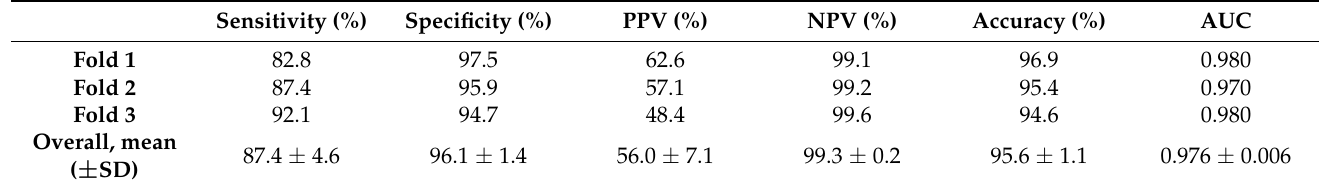
Table 2. Three-fold cross validation .